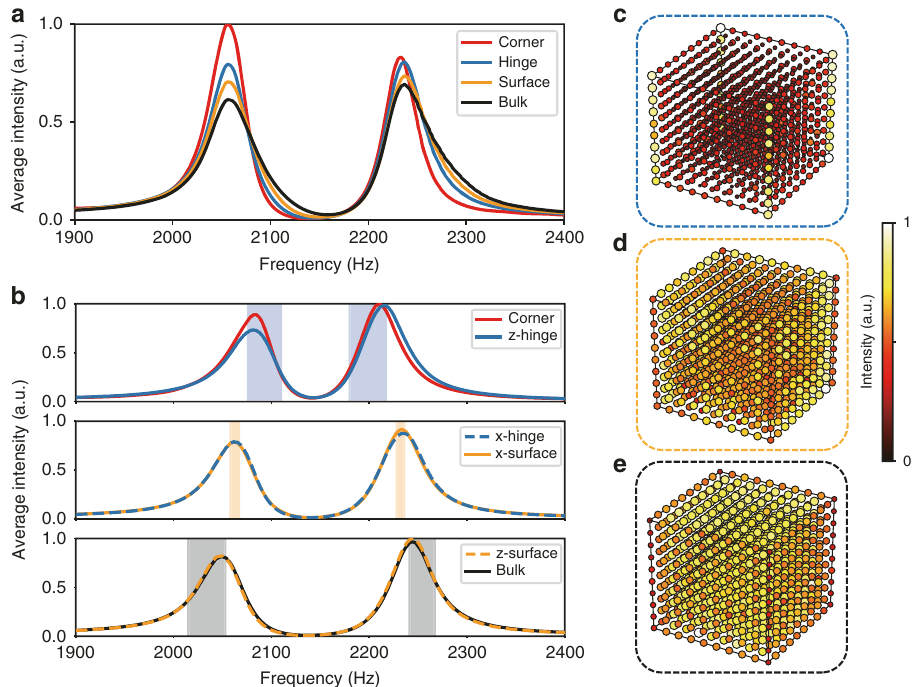
Fig. 4 Experimental demonstration of two samples with trivial bulk octupole moment. a Measured average intensity spectra for the sample with γ > λ . b Measured average intensity spectra for the sample with γ x,y < λ x,y and γ z > λ z . Spectra with peaks located at similar frequencies are plotted in the same fi gure. Shaded regions denote the frequency regions for intensity integration. c – e Spatial distributions of the acoustic response intensity, integrated over the spectral peaks in b . These results reveal that the peaks in b correspond to hinge, surface and bulk states,